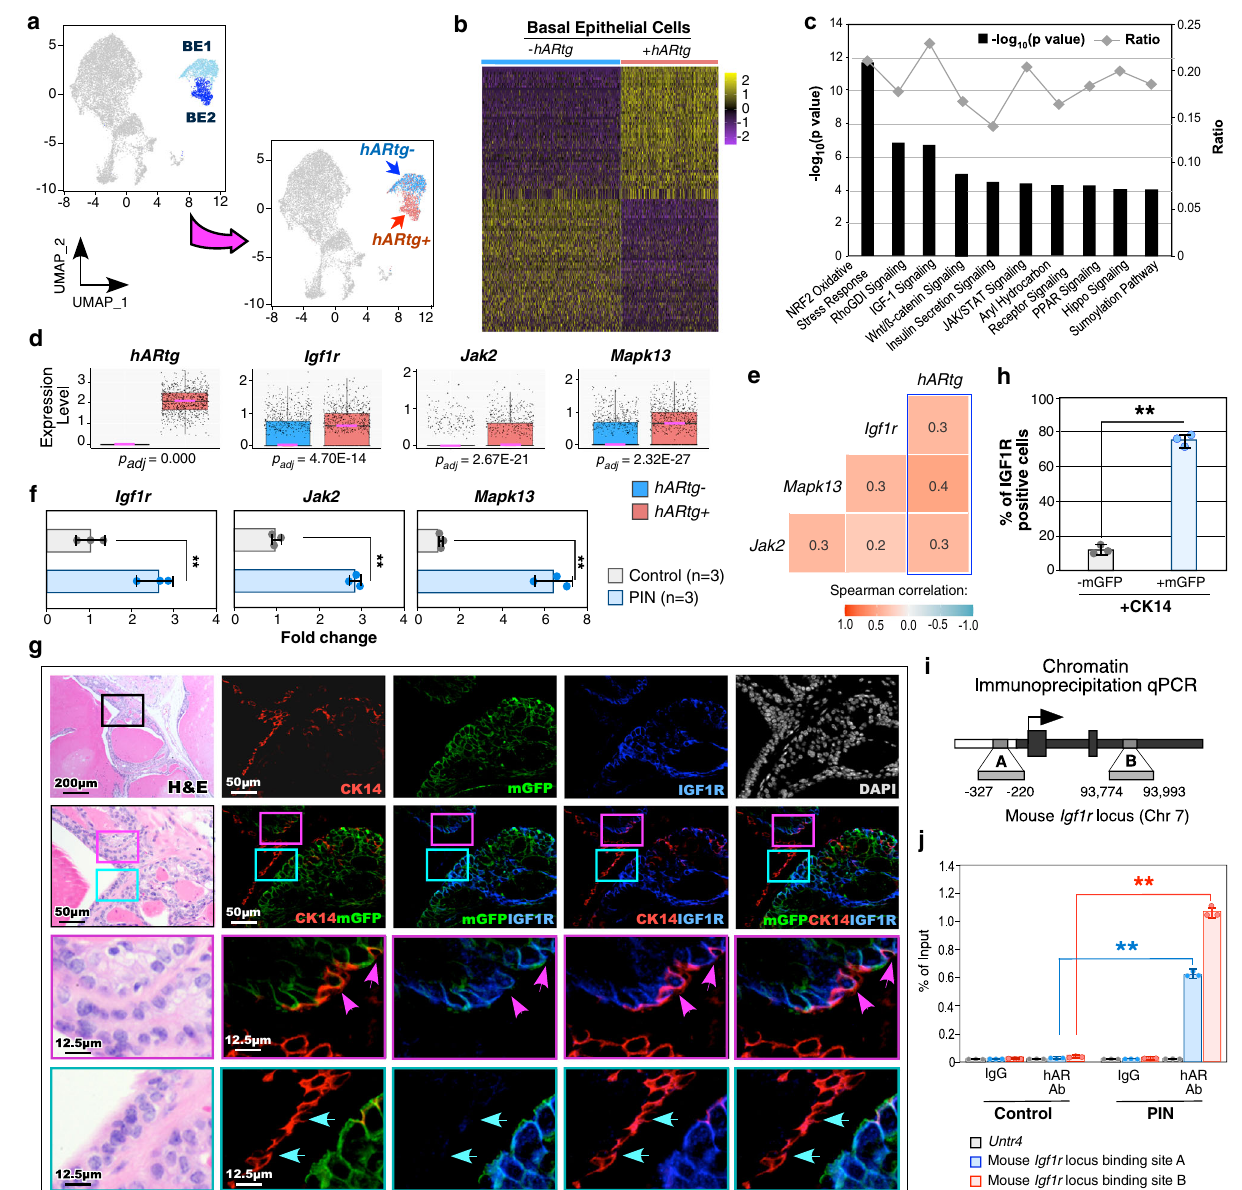
Fig. 3 | Transgenic AR expression elevates IGF1 signaling in atypical Osr1 -dri- ven prostatic basal epithelial cells within PIN lesions. a UMAP plot indicating basal epithelial (BE) cells from PIN and PCa tissues of R26 mTmG/hAR : Osr1 Cre/+ mice (left), colored by hARtg expression (right). b Heatmap showing top 50 differen- tially expressed genes (DEGs) between hARtg +and hARtg - BE cells. c Ingenuity pathway analysis (IPA) pathway analysis of DEGs comparing hARtg +and hARtg - BE cells. Fisher ’ s exact test (two-sided). Ratio denotes the number of DEGs comparedwiththetotalnumberofgenesassociatedwiththecanonicalpathway. d Box-plots representing scaled expression for the indicated genes between hARtg +( n =749) and hARtg - ( n =933) BE cells. Pink lines mark the median; top andbottomlinesofboxesindicatetheboundariesofthe fi rstandthirdquartiles, respectively; the top and bottom whiskers show the maximum and minimum values, respectively, excluding outliers. Wilcoxon rank-sum test (two-sided) fol- lowed by Benjamini-Hochberg correction. e Heatmap of pairwise Spearman correlation between indicated gene expression in BE cells. Numbers indicate